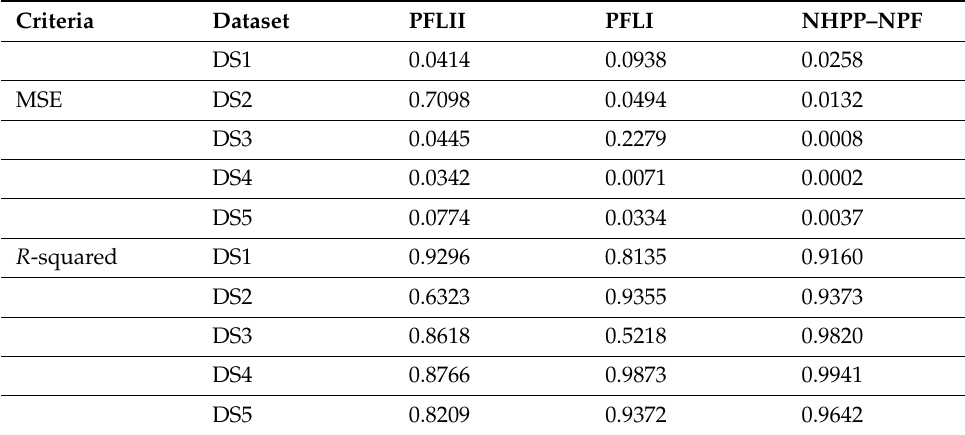
Table 3. Results of model comparisons for various datasets. Criteria